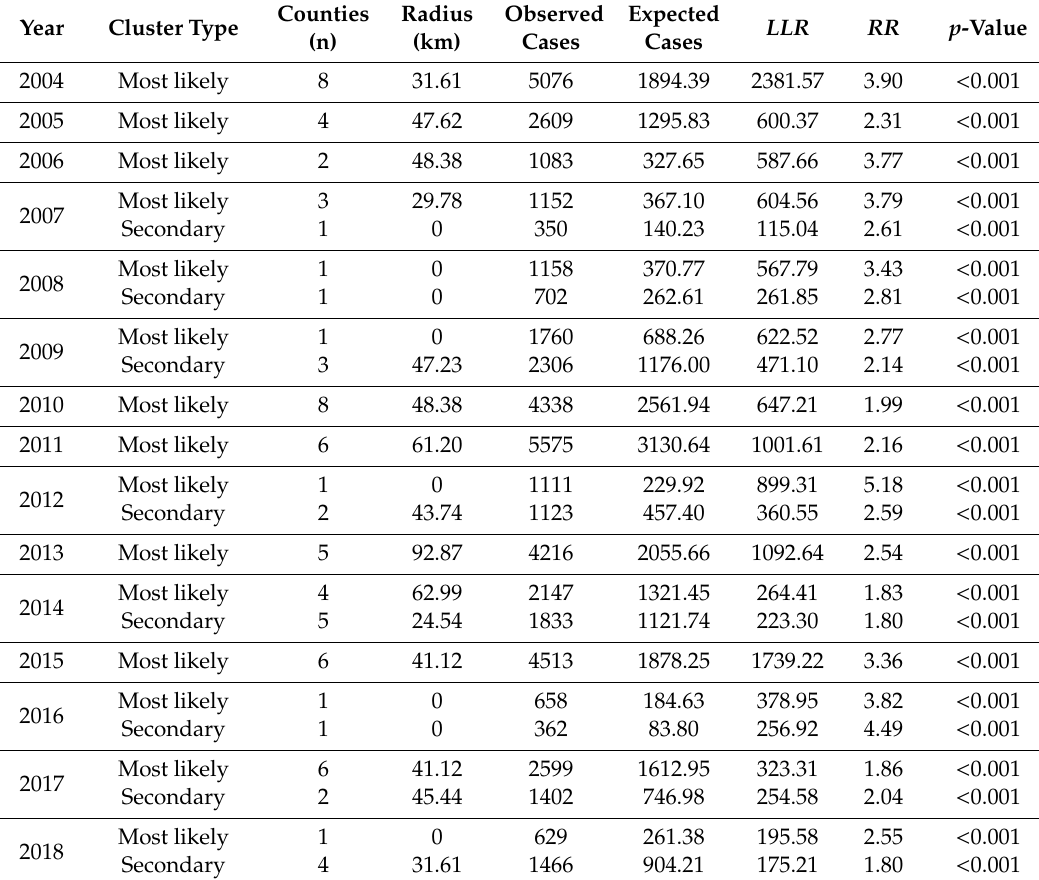
Table 2. Yearly spatial clusters of mumps cases in Chongqing from 2004 to